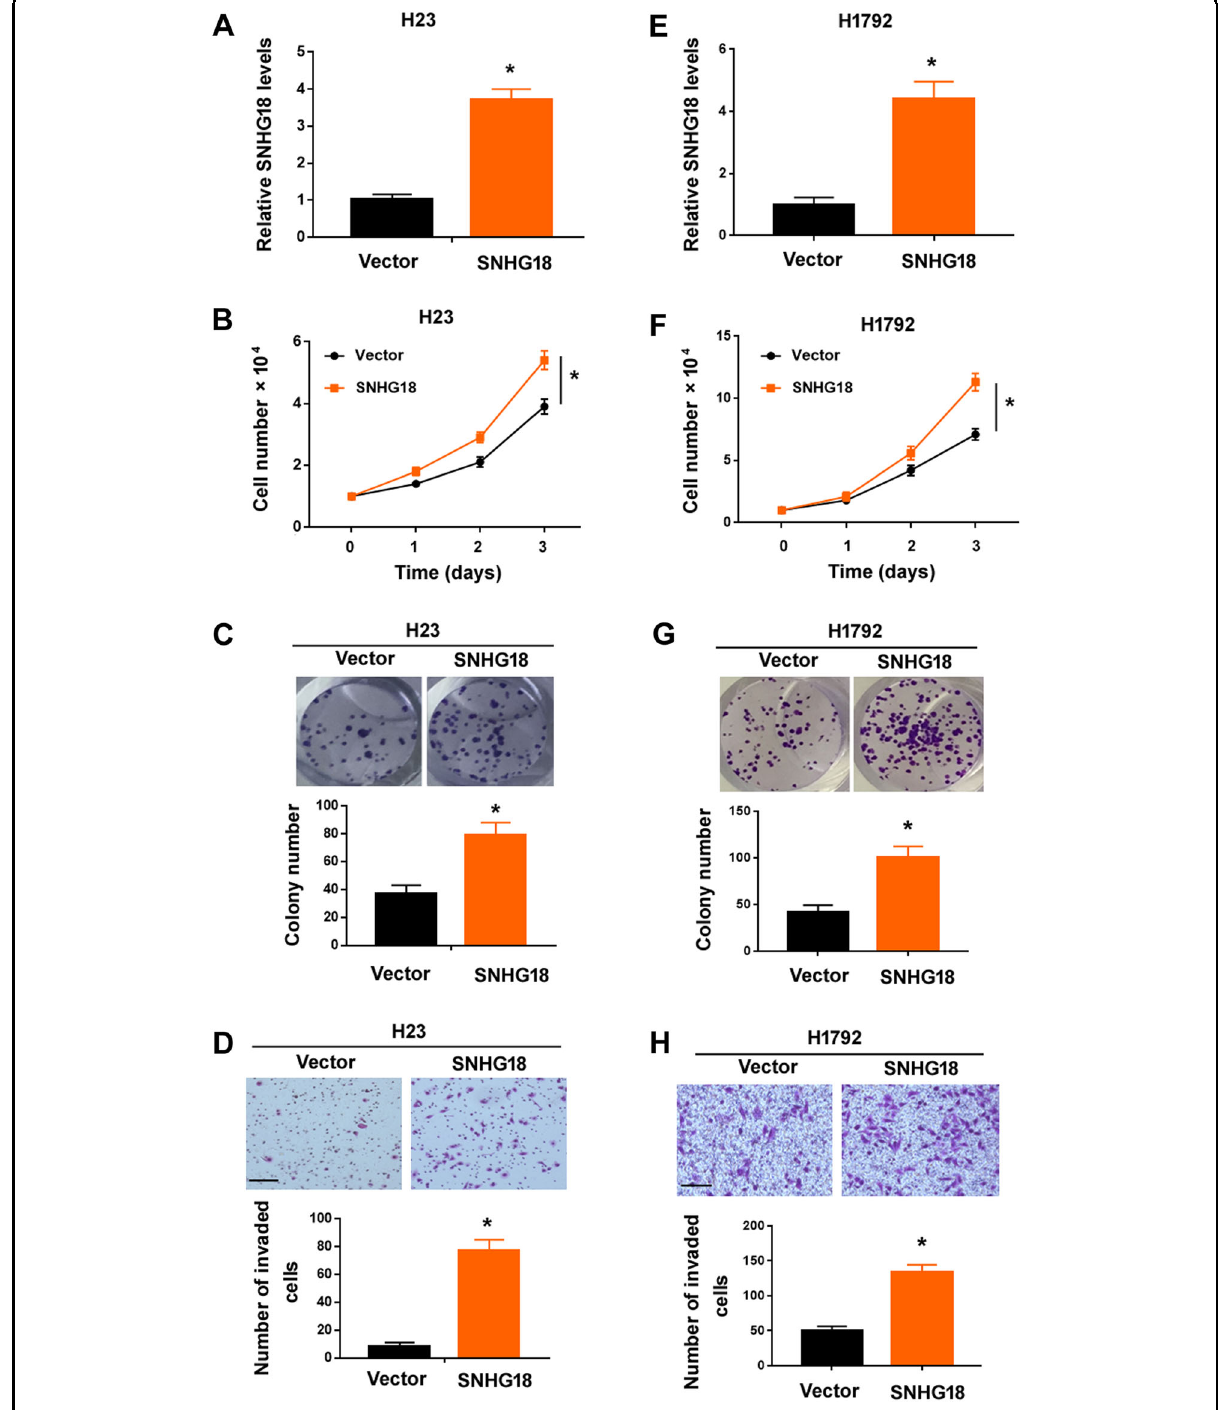
Fig. 5 Overexpression of SNHG18 promotes NSCLC cell proliferation and invasion in vitro. A Quantitative PCR analysis of SNHG18 in H23 cells transfected with empty vector or SNHG18-expressing vector. n = 3. B Ectopic expression of SNHG18 increased the proliferation of H23 cells. n = 4. C Colony formation assay was performed to determine the ability of SNHG18-overexpressing H23 cells in forming colonies. n = 3. D Transwell invasion assay was used to assess the invasive ability of H23 cells with or without overexpression of SNHG18. n = 3. E Analysis of SNHG18 expression in H1792 cells. n = 3. F – H Overexpression of SNHG18 enhanced the F proliferation ( n = 4), G colony formation ( n = 3), and H invasion ( n = 3) of H1792 cells. Scale bar = 100 μ m in ( D , H ). * P < 0.05 vs . vector. In all panels, Student ’ s t -tests were